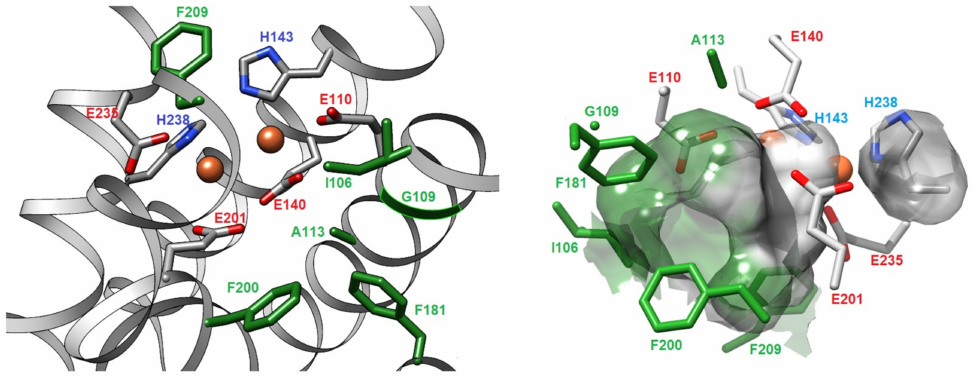
Figure 2. Two di ff erent representations of the 3D model of PmlD active site. Ribbon model (on the left) shows amino acids of interest as sticks in the helix bundle, while surface model (on the right) represents a hydrophobic pocket in the active site. The carboxylate-bridged diiron center presented in Corey-Pauling-Koltun (CPK) coloring, amino acids chosen for mutagenesis displayed in green. Orange spheres represent two iron